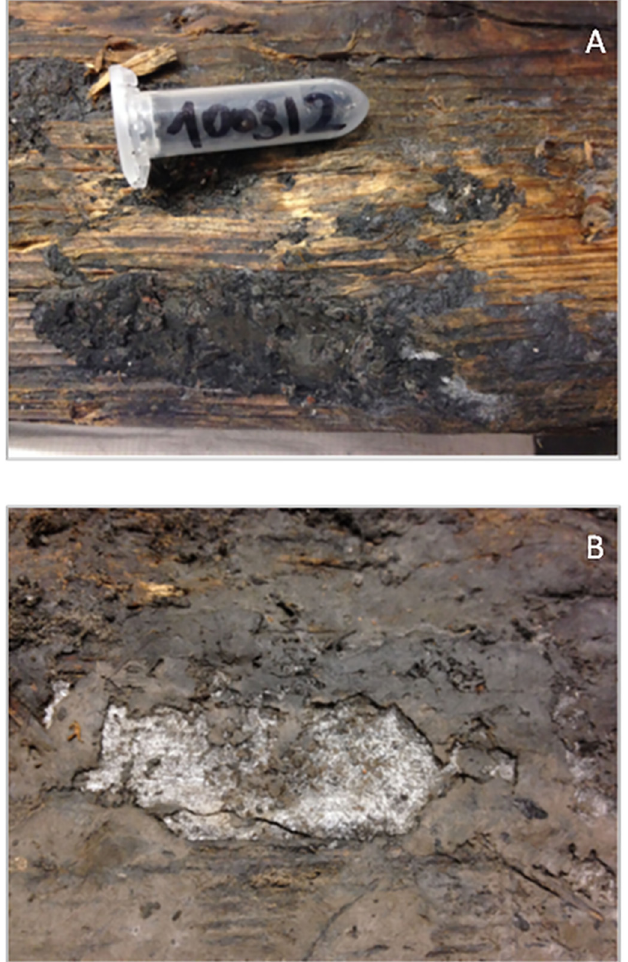
Fig 2. Stairs surface. Fungal mycelia developing on the wood and on the old dark deposits on the surface of the stairs ( A ). Evolution of salt crusts due to the storing conditions promoting local variations in the salt content on the stairs ( B